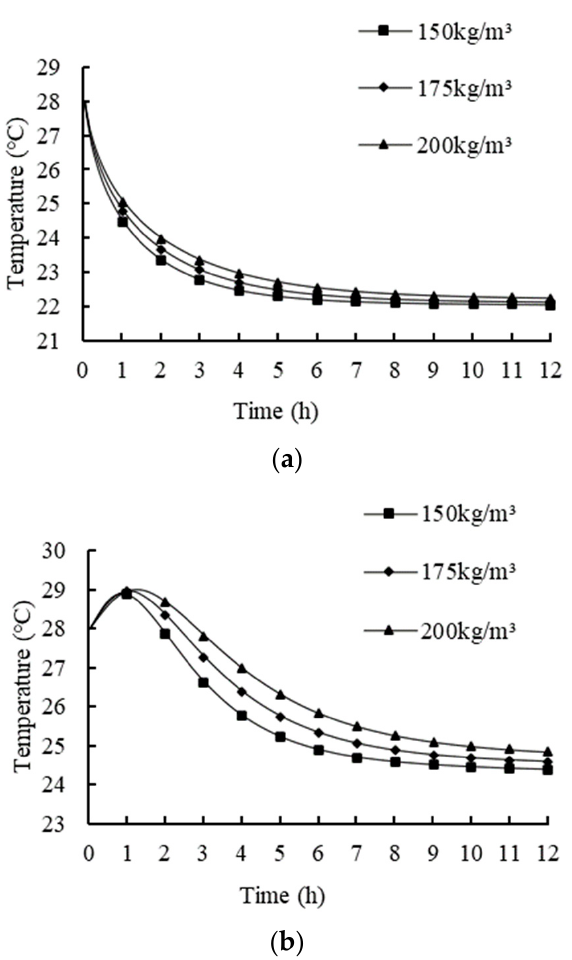
Figure 14. Temperature variations of the fresh tea leaves with different bulk densities: ( a ) average temperature; and ( b ) maximum temperature.